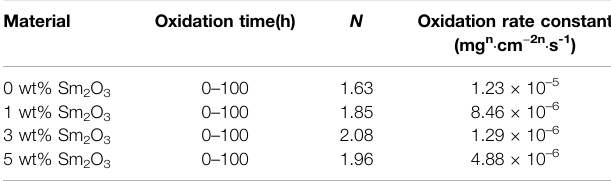
TABLE 2 | Oxidation rate constants ( k p ) of the NiCoCrAlY- x Sm 2 O 3 .